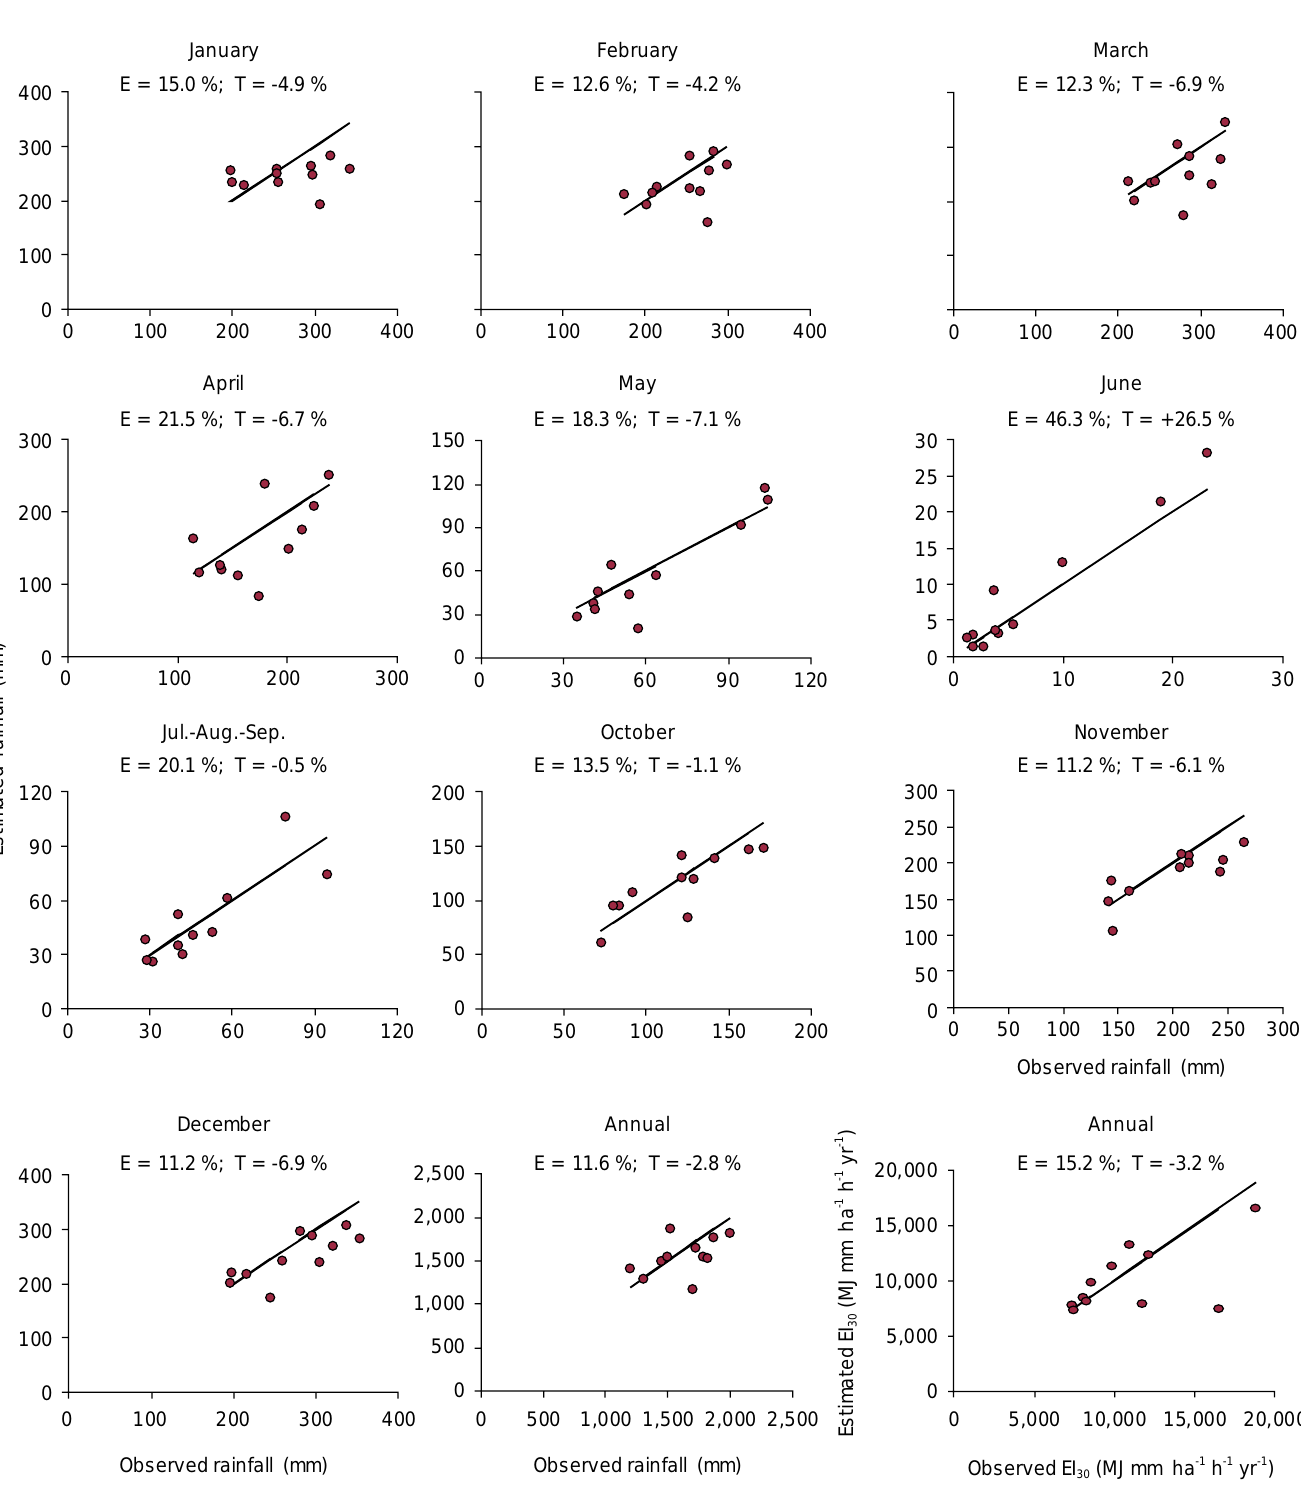
Figure 2. Validation of the statistical models for rainfall data and R-factor in the state of Tocantins including computation of average error (E) and tendency (T) values, as well as graphic predictor of predicted the dispersion of predicted values around a 1:1